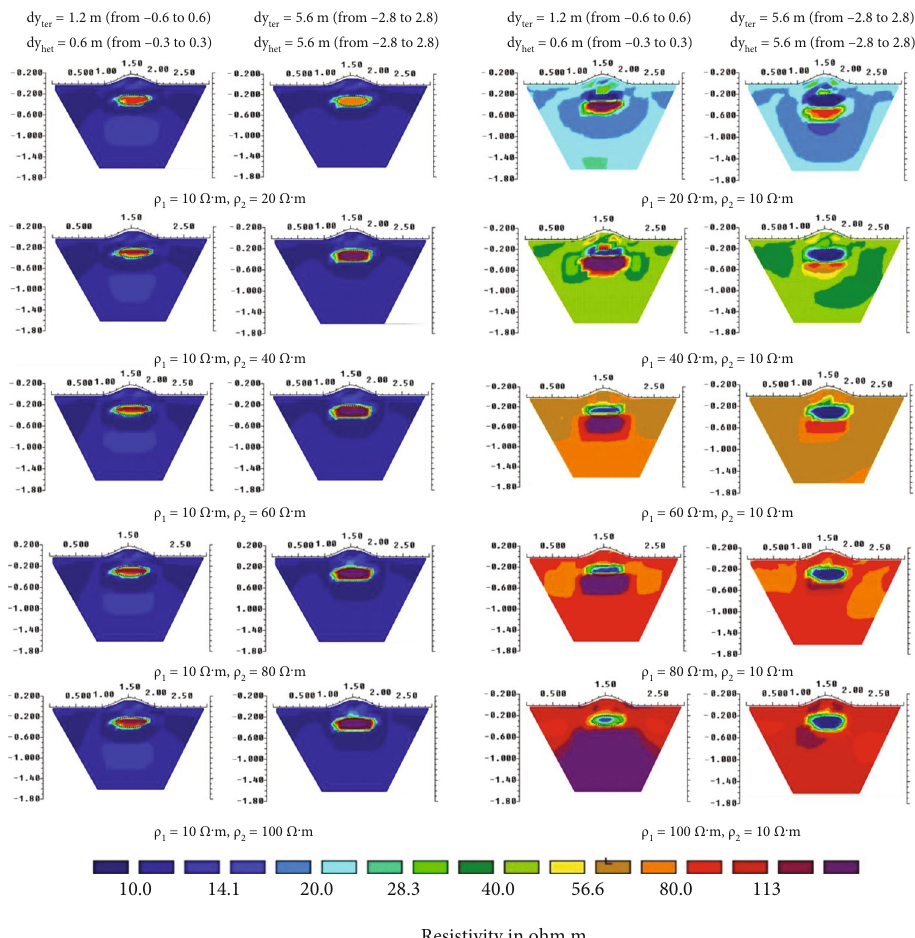
Figure 7: The in fl uence of the resistivity contrast ratio of a 3D inhomogeneous medium with the ground surface topography on the results of 2D